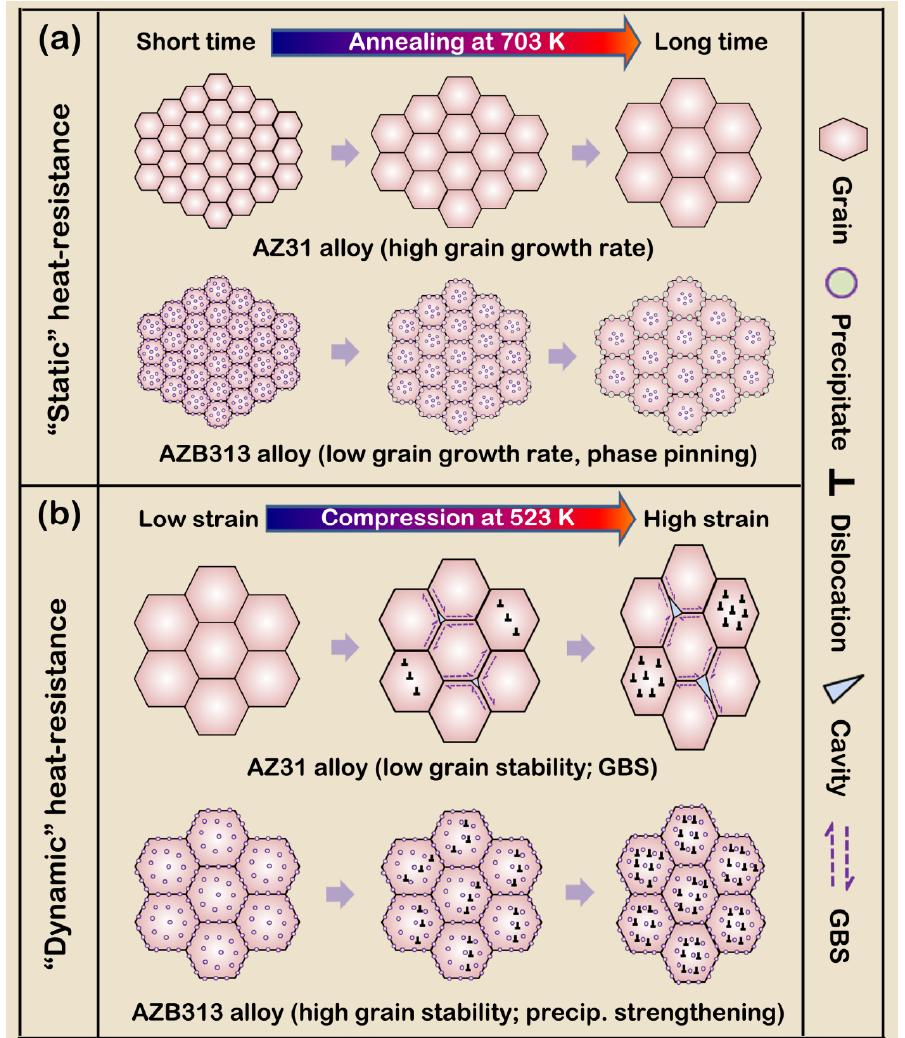
Figure 15. ( a ) “Static” and ( b ) “dynamic” heat resistance mechanisms of both as-extruded AZ31 and AZB313 alloys.